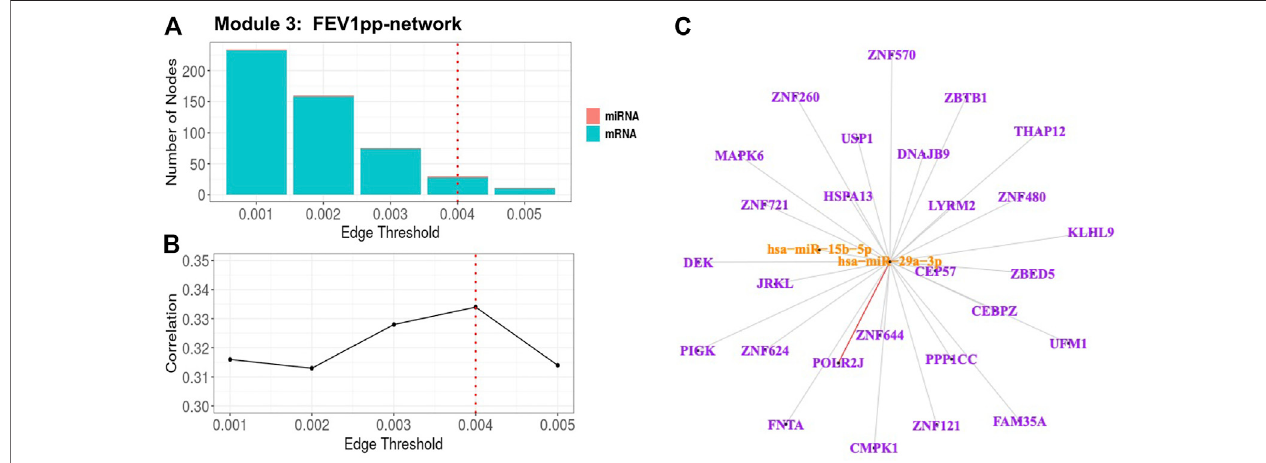
FIGURE 5 | FEV 1 pp-associated miRNA – mRNA network (Module 3 in Table 3 ) pruning with grid search. The edge threshold candidates were de fi ned by the distribution of the edges in the raw network. (A) The number of nodes including miRNA (red) and mRNA (light blue) with different edge thresholds. (B) The absolute correlation between FEV 1 pp and the 1st PC (i.e., fi rst principal component) of the trimmed network under different edge thresholds. The red dotted line indicated the chosen optimal edge threshold (0.004) for network trimming, which achieved a maximum correlation (0.33) between FEV 1 pp and the 1st PC. (C) The trimmed miRNA – mRNA network (module 3 in Table 3 ) with the optimal edge threshold (0.004). The orange nodes denote miRNAs while the purple nodes denote genes. The signs of edges are based on the correlation of the original expression data between the nodes. Red and blue edges represent negative and positive correlations respectively. Edge thickness corresponds to the strength of relationship between the nodes based on the canonical weights.